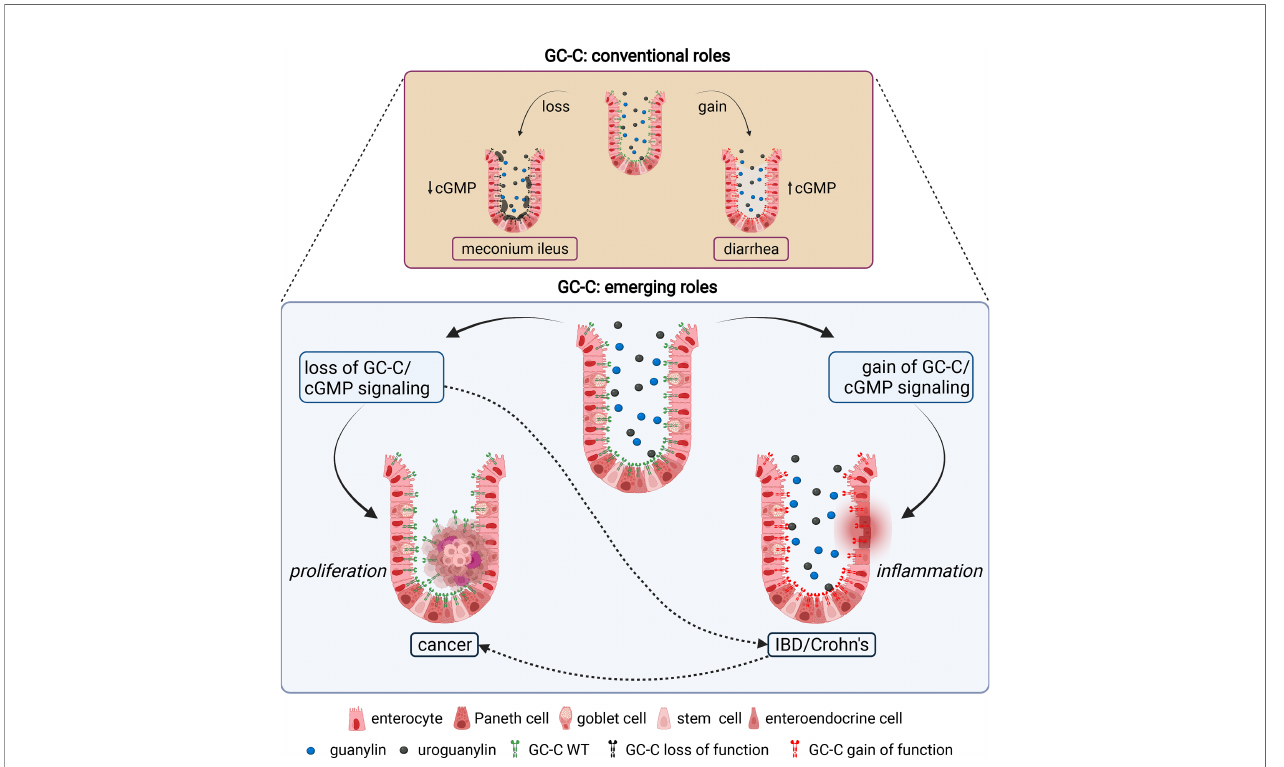
FIGURE 1 | Canonical and emerging roles of GC-C in intestinal homeostasis. The conventional roles of GC-C in the regulation of intestinal fl uid ion homeostasis and associated human pathologies are well established. Homozygous and compound heterozygous loss of function mutations in GC-C cause meconium ileus due to decreased fl uid and ion secretion. Gain of function mutations in GC-C cause congenital secretory diarrhea due to increased fl uid and ion secretion. The emerging roles of the GC-C/cGMP signaling axis in the pathogenesis of several human diseases, most notably colorectal cancer and in fl ammatory bowel disease, are becoming evident. Loss of GC-C/cGMP signaling because of prominent downregulation of guanylin and uroguanylin is associated with tumorigenesis. Gain of GC-C/ cGMP signaling upregulates interferon-stimulated genes and STAT1 activation in intestinal tissue, leading to chronic in fl ammation and in fl ammatory bowel disease. Impaired gut barrier integrity and dysbiosis of the microbiome associated with loss (or gain) of GC-C mediated signaling may be linked to in fl ammatory bowel disease (or colorectal cancer) are shown in dotted lines. The fi gure was prepared using